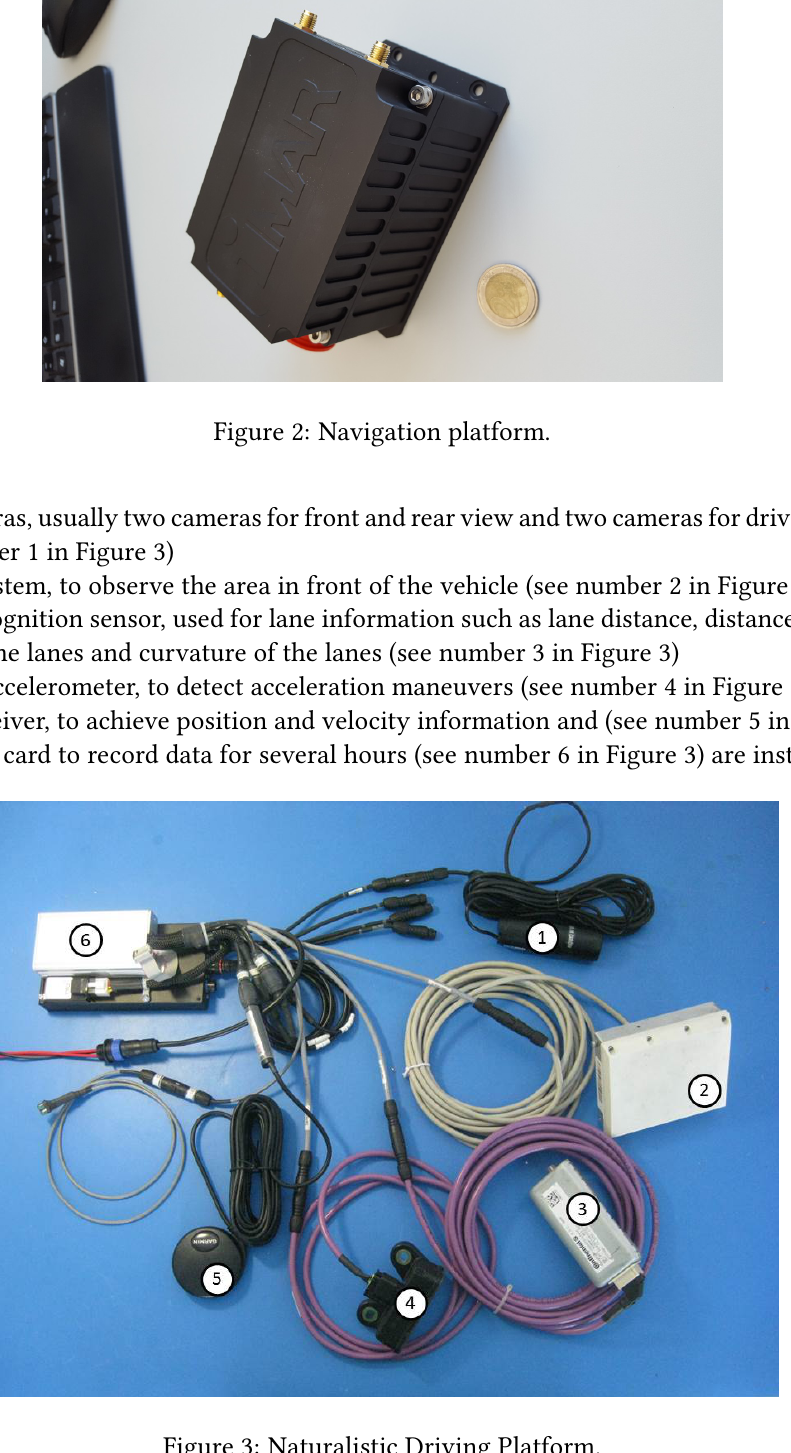
Figure 3: Naturalistic Driving